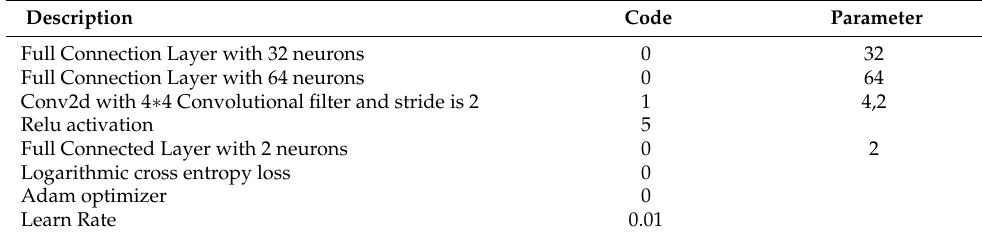
Table 4. The Sequence Corresponding to a five-layer